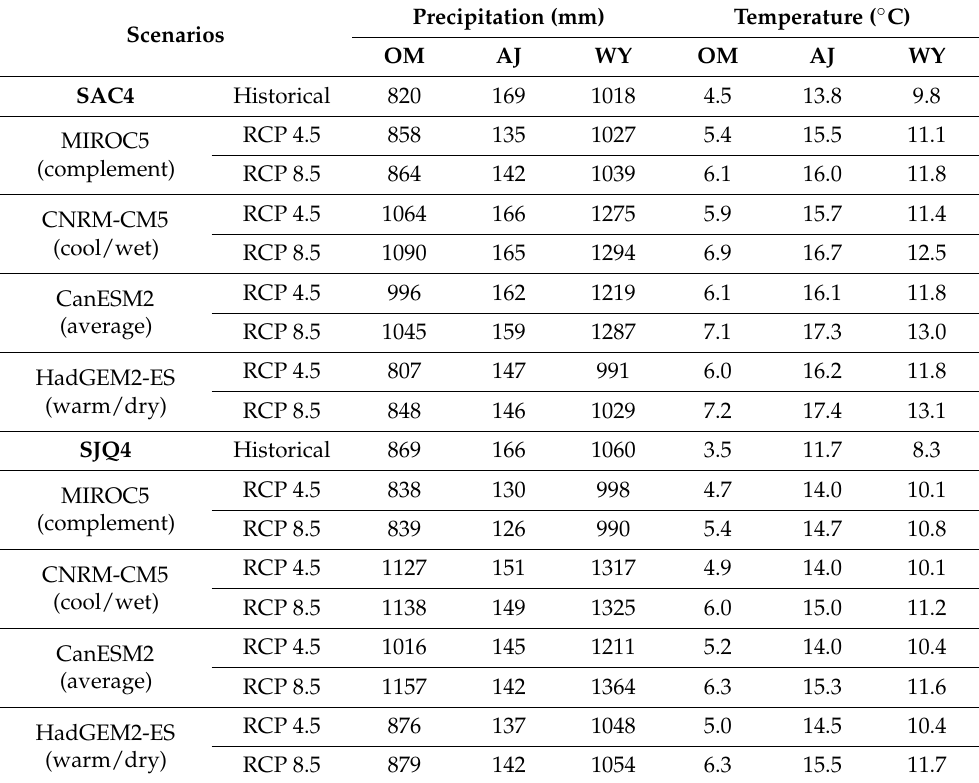
Table 2. The mean of historical (1920–1999) and projected (2020–2099) precipitation and temperature data at annual and seasonal